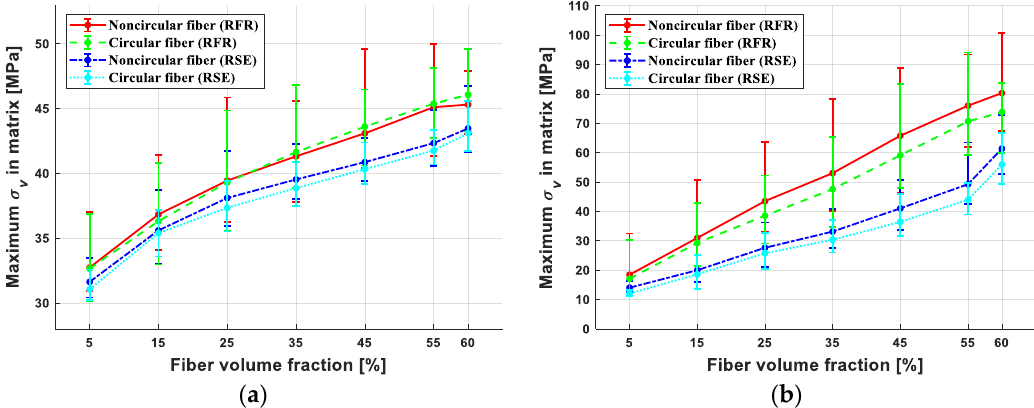
Figure 11. Von Mises stress with 1% tensile strain for V f = 60% of T300 / PR319: ( a ) RVEs with noncircular fibers and ( b ) RVEs with circular fibers.